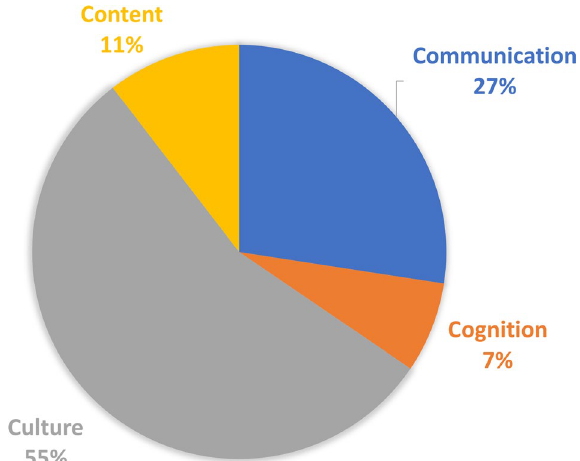
Fig. 4 Proportion of statements related to the 4Cs in group